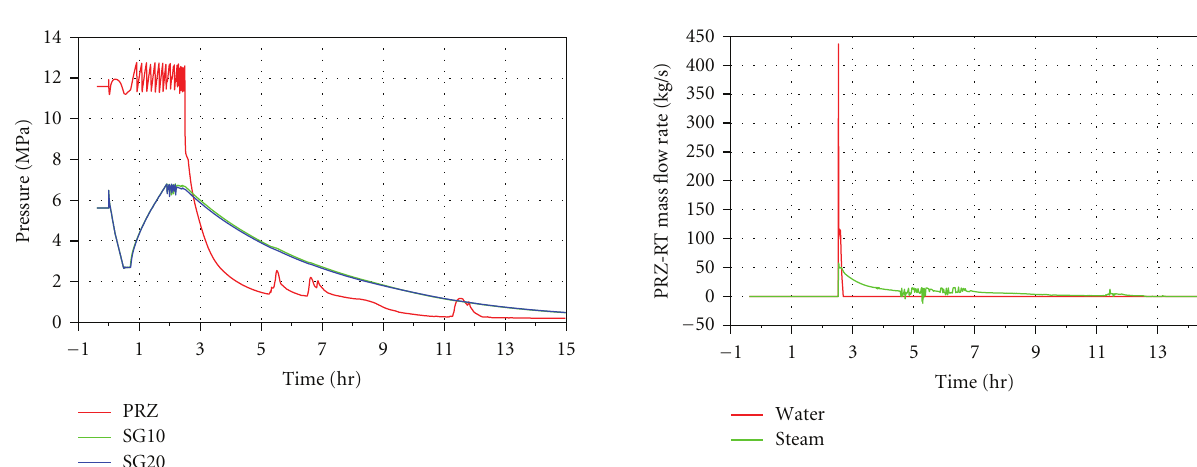
Figure 15: Pressure in pressurizer and SG10 and SG20.